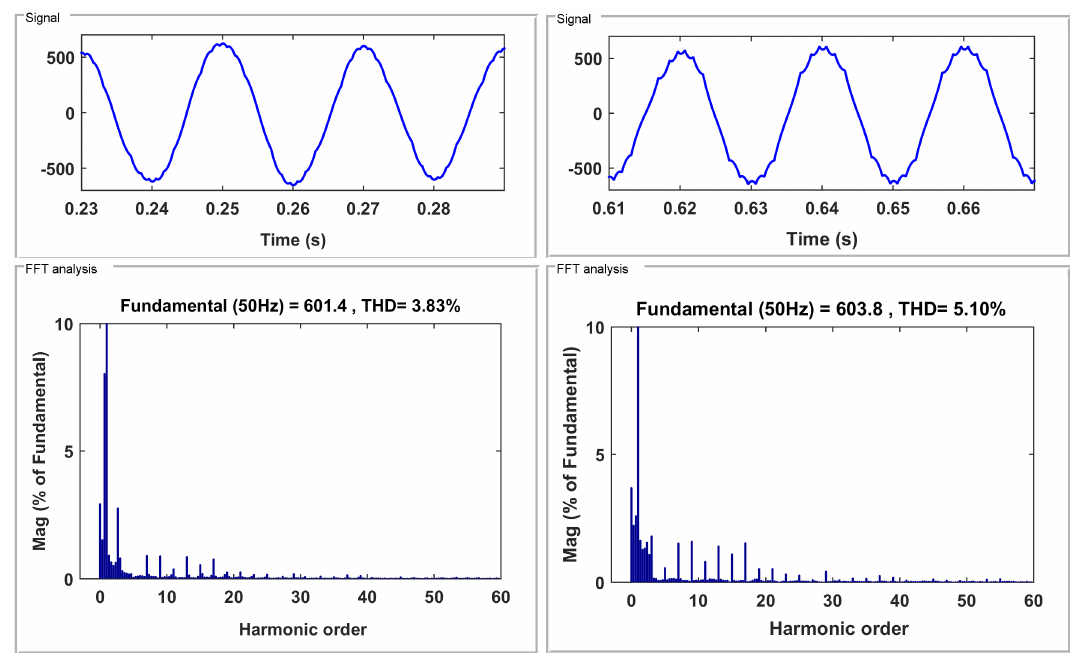
Figure 4. STATCOM currents harmonic spectra during continuous loads of inductive and capacitive